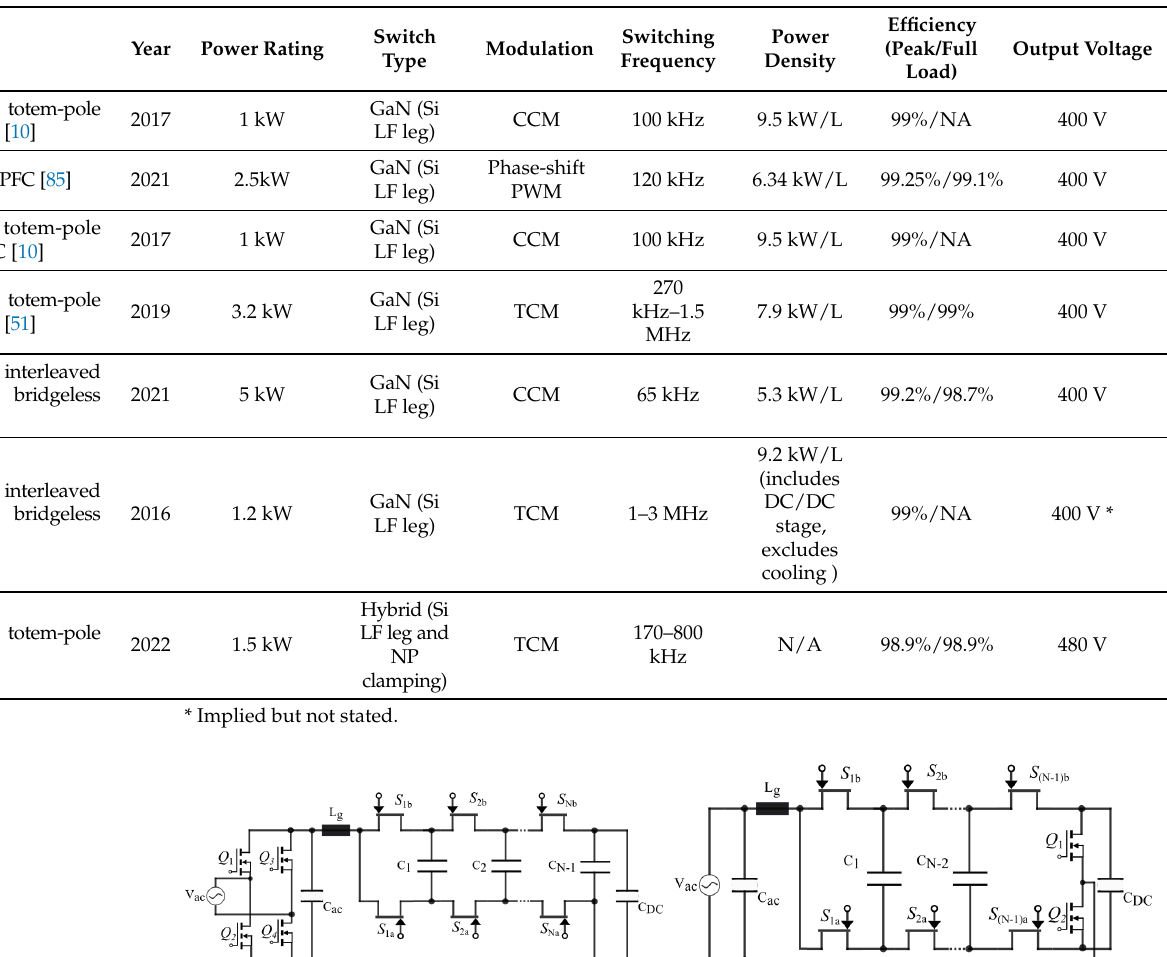
Table 8. Summary of GaN-based phase modular PFC topologies.